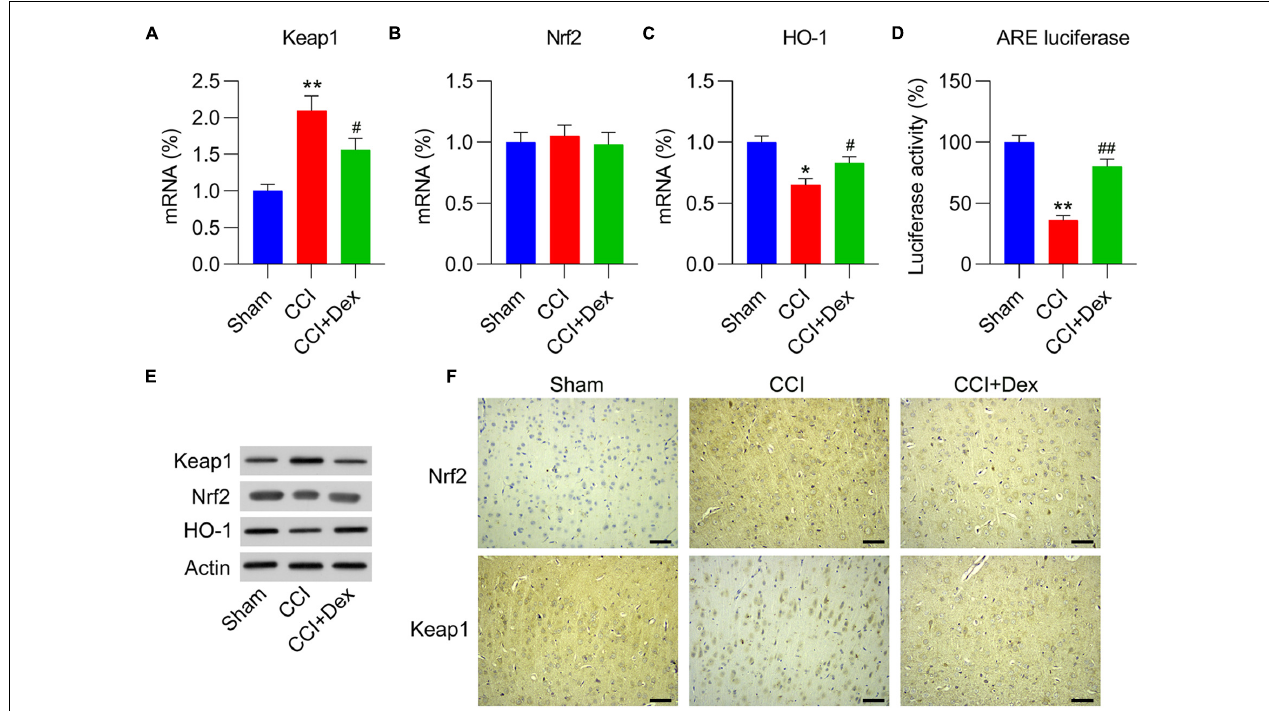
FIGURE 3 | Role of Dex in Keap1–Nrf2 pathway expression and activation in CCI-induced rats. (A,B) mRNA expression levels of Keap1 and Nrf2 were measured using quantitative polymerase chain reaction (qPCR). (C) mRNA expression levels of HO-1 were measured using qPCR. (D) Isolated microglia were transfected with ARE luciferase vector, followed by determination of luciferase activity in the cells at 36 h after transfection. (E) Protein expression levels of Nrf2, Keap1, and HO-1 were measured using western blotting. (F) Immunohistochemical staining of Keap1 and Nrf2 expression in spinal cord tissues. Scale bar, 50 µ m. * P < 0.05, ** P < 0.01 vs. Sham group; # P < 0.05, ## P < 0.01 vs. CCI group.